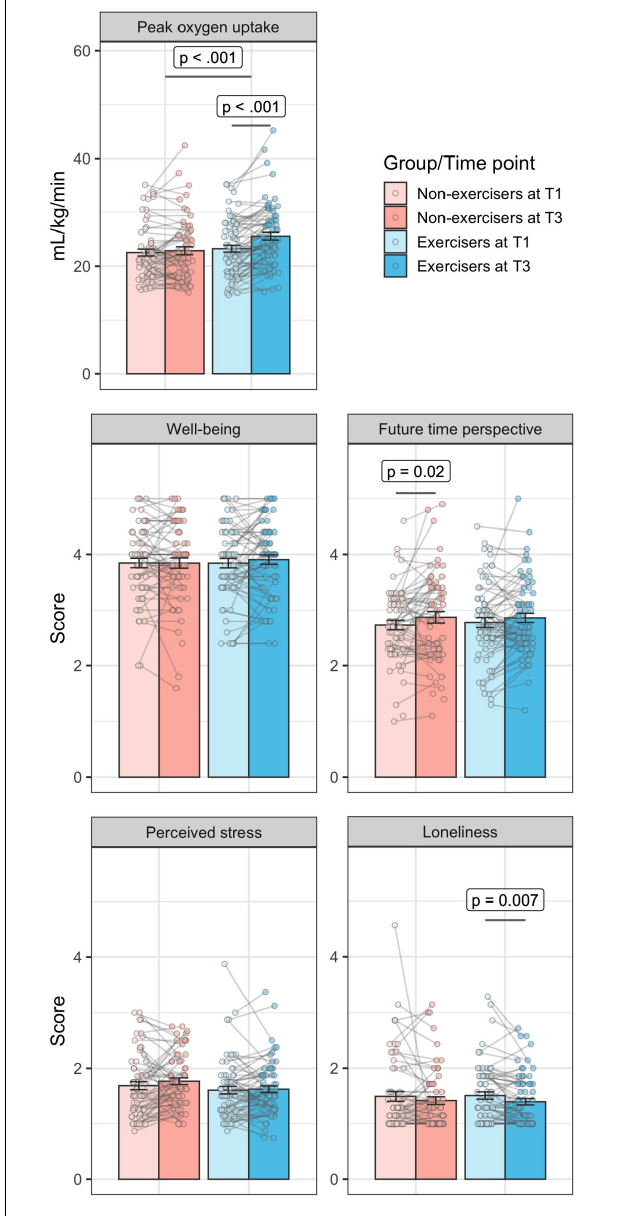
FIGURE 1 | A significant change over time in peak oxygen update (VO 2 peak) in all exercisers (displayed in blue) in comparison to all non-exercisers (displayed in red). Contrary to expectations, there was no significant time by group interactions in well-being, perceived stress, loneliness, or future time perspective. Error bars represent ± 1 standard error